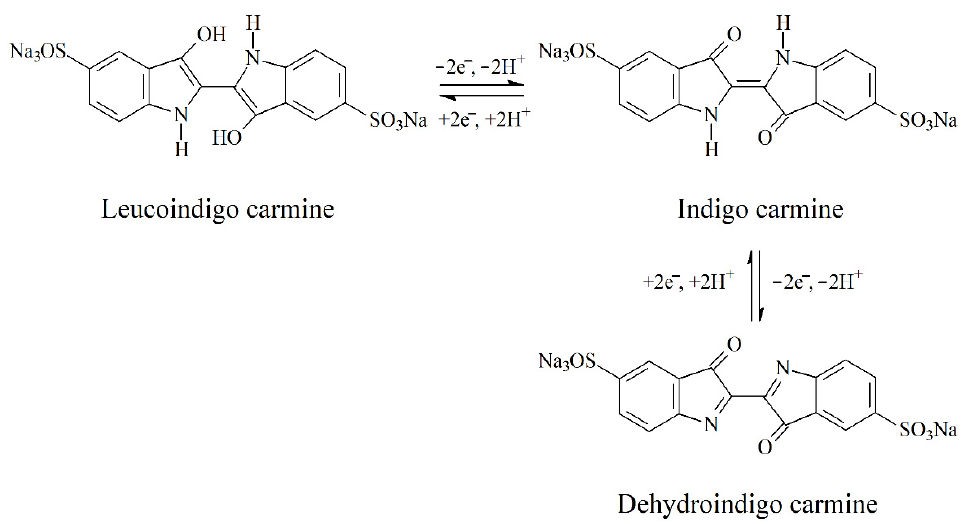
Figure 2. Redox behavior of indigo carmine.